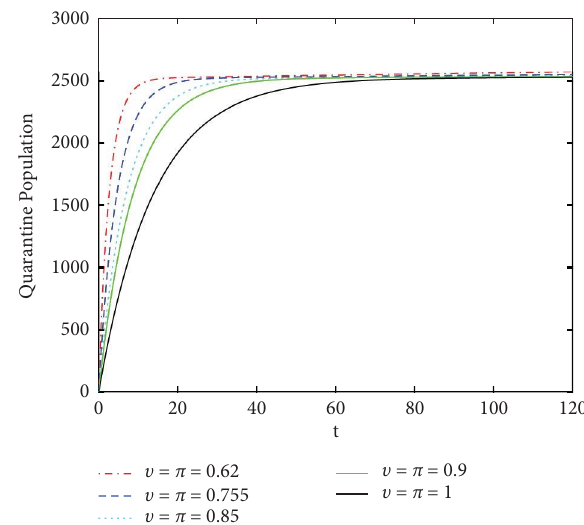
Figure 23: Te dynamics of quarantine human population for various fractal-fractional